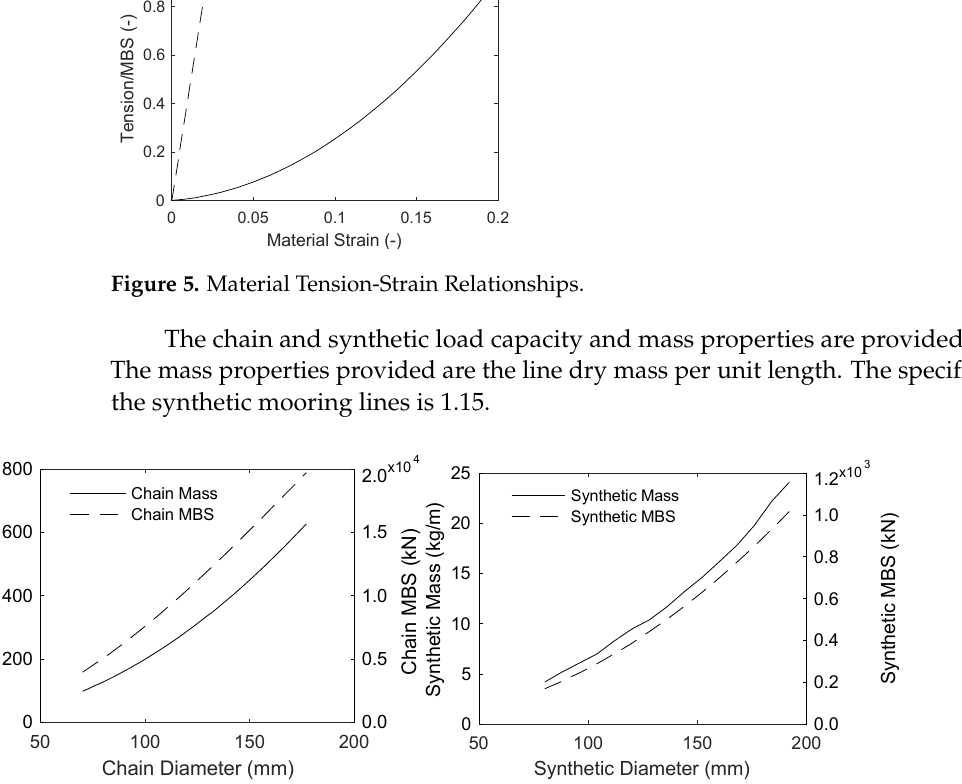
Figure 6. Dry Chain Mass and Chain Load Capacity ( left ) and Dry Synthetic Mass and Synthetic Load Capacity ( right ).